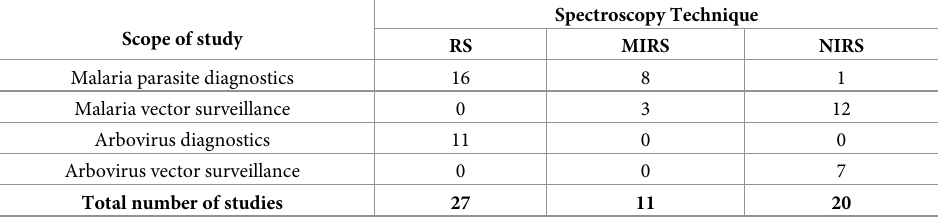
Table 1. Summary of all articles included in this literature review sorted by type of spectroscopy method and scope of study. Scope of